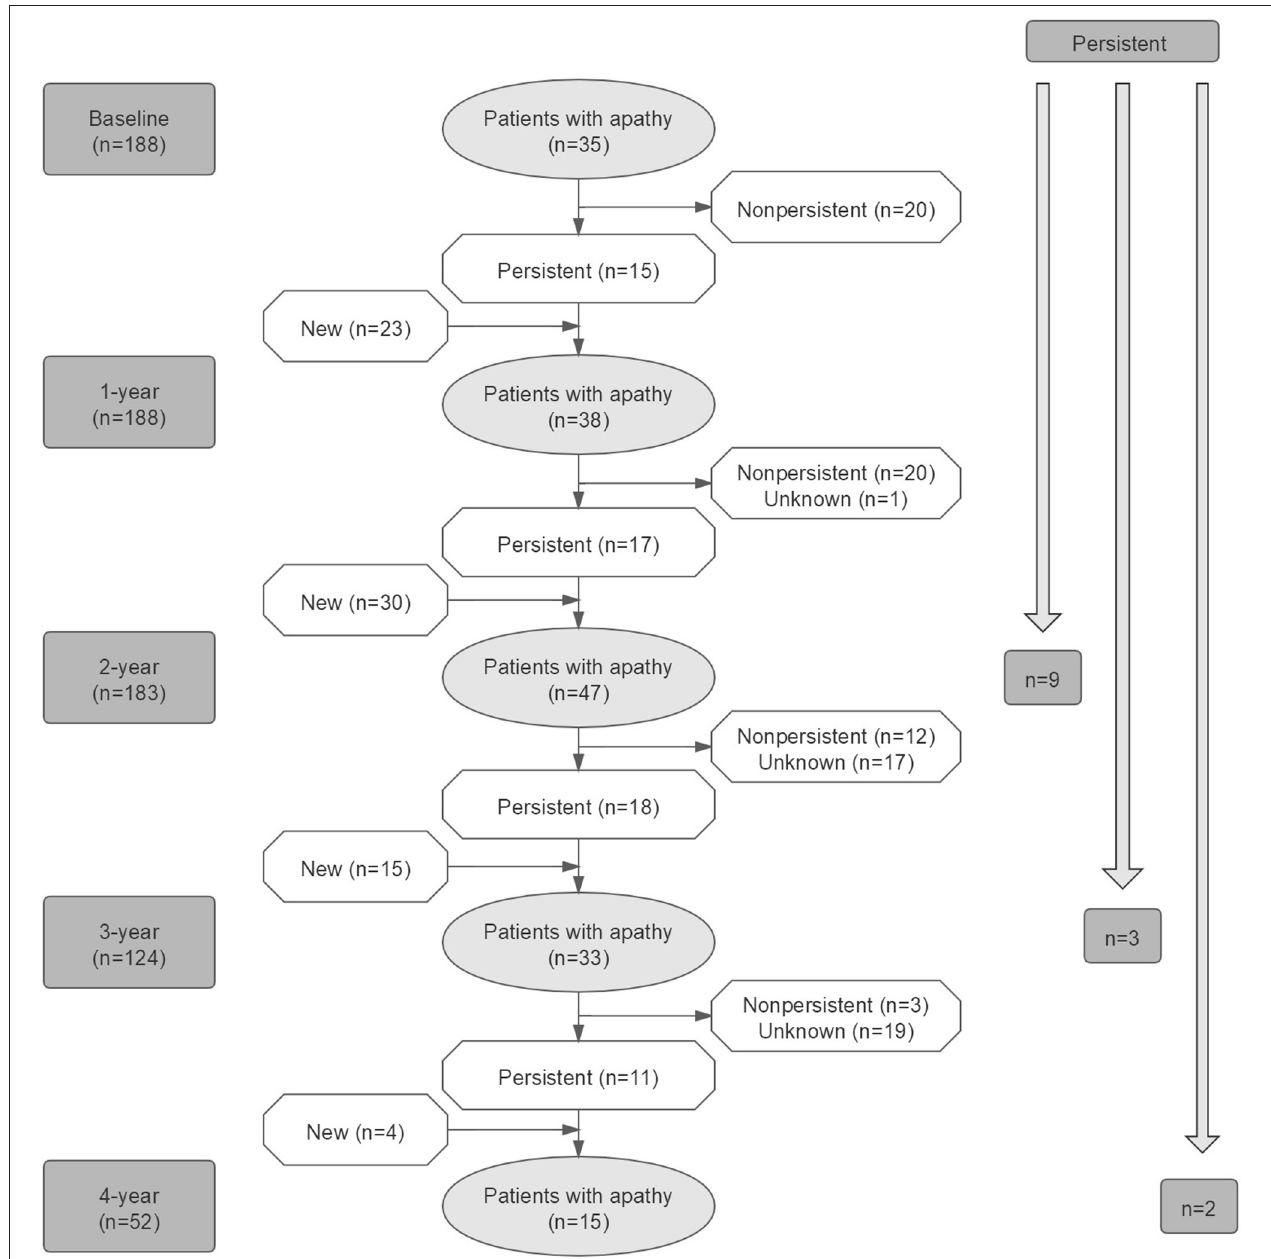
FIGURE 2 | Evolution of apathy in patients with PD over